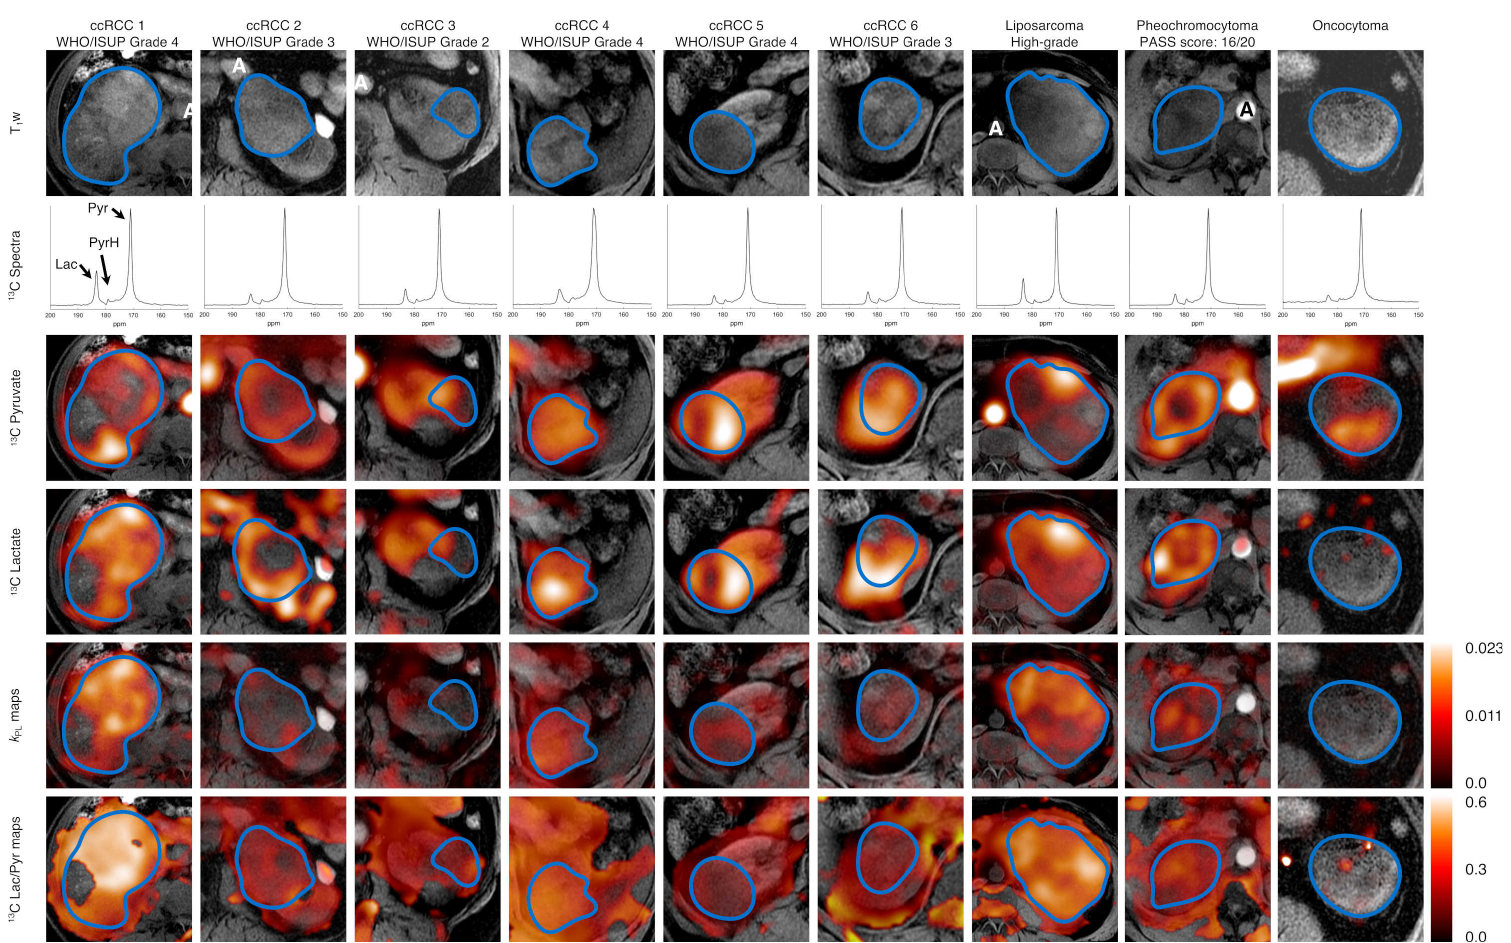
Figure 1. Summary of all tumors included in this study. Axial T 1 w images as a reference. Non-localized 13 C spectra of the axial slice containing the largest tumor cross-section summed over all timepoints. 13 C-Pyruvate and 13 C-lactate signal summed over all time points superimposed on an axial T 1 w image of the largest tumor cross-section. The border of the tumor is outlined in blue. A: Aorta, Lac: Lactate, Pyr: Pyruvate, PyrH: Pyruvate hydrate. A PASS score (Thompson, The American Journal of Surgical Pathology: May 2002) of ≥4 is associated with a potential for clinical ly aggressive behavior in pheochromocytoma. 1 H-MRI.